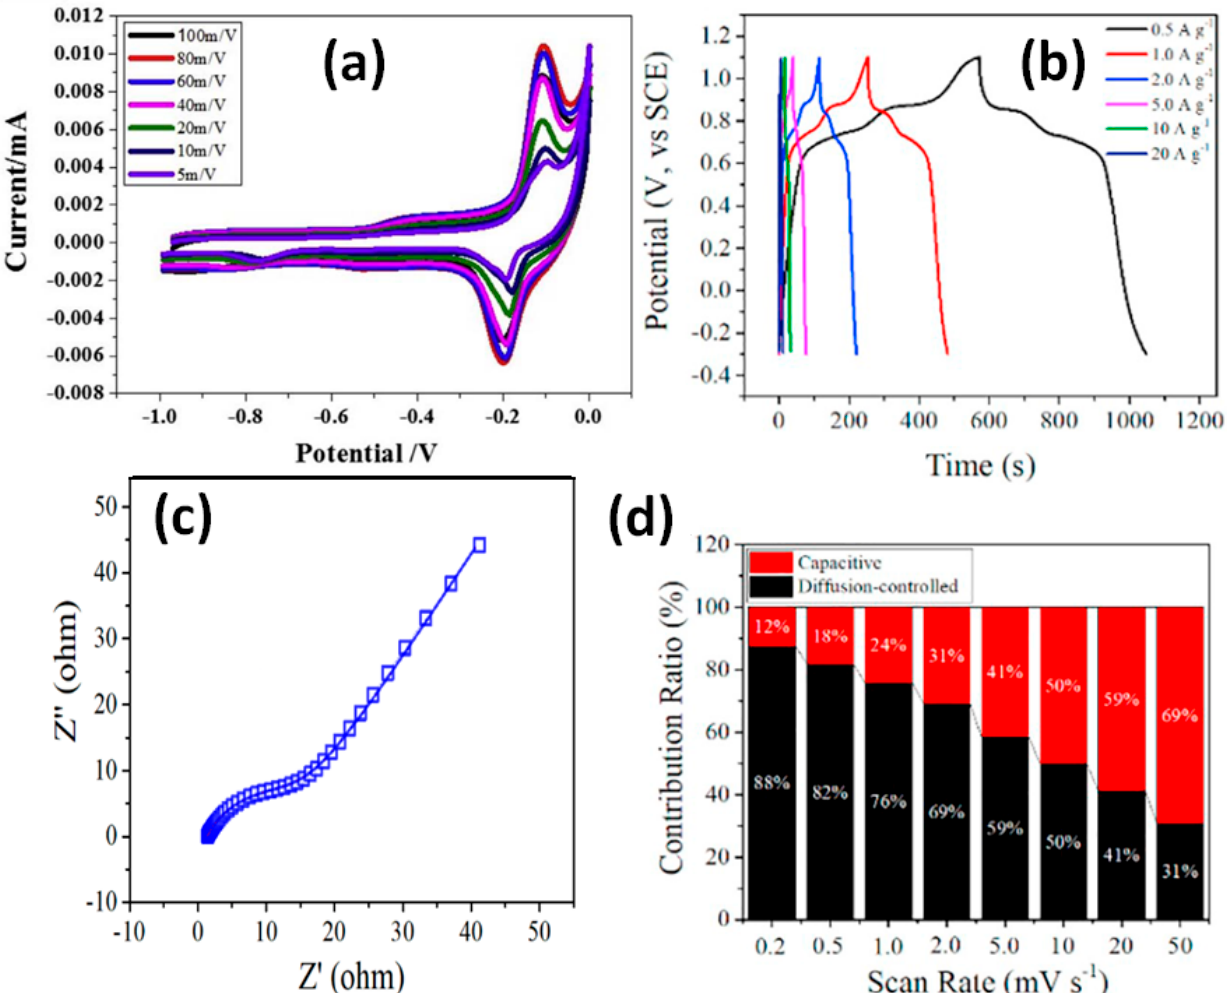
Figure 23. CV curves obtained at different scanning rates for rGO-CNT-Co 3 O 4 -SnO 2 -AB-PTFE composite on Ni foam ( a ) (Reproduced with permission of [54]. Copyright Elsevier, 2017). Electrochemical performance of LiMn 2 O 4 -CNT-graphene nanocomposite: GCD at different current densities ( b ), EIS Nyquist plots of the electrode after cycling ( c ). Contribution ratios of capacitive and diffusion-controlled processes at various scan rates ( d ) (Reproduced with permission of [56]. Copyright Elsevier, 2019).